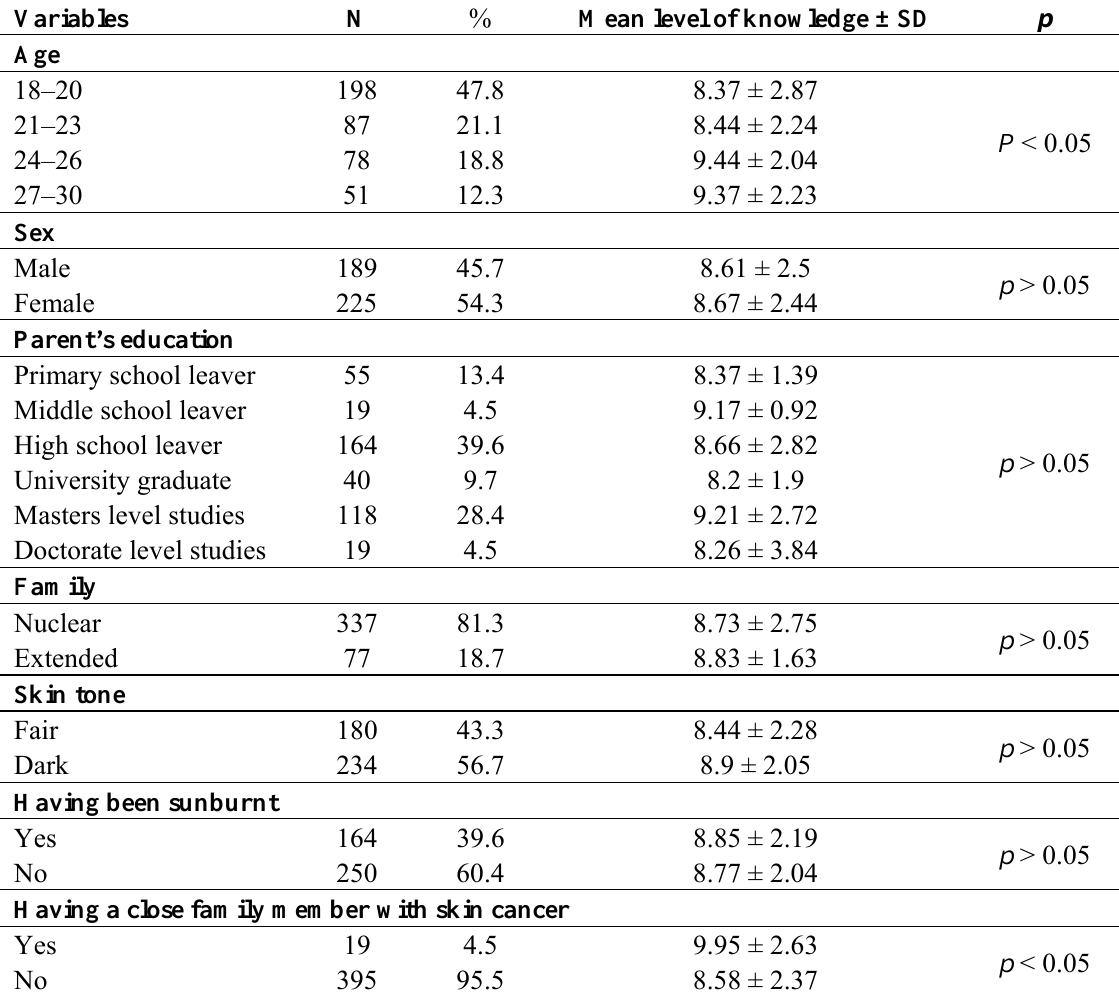
Table 1. Level of knowledge of students based on a variety of